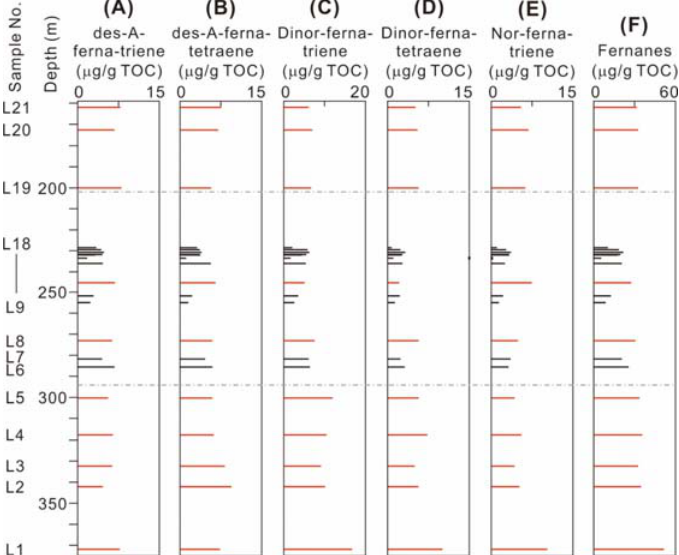
Figure 12. Fernanes in saturated and aromatic hydrocarbon fractions of oil shale and coal. ( A ) des- A-ferna-triene. ( B ) des-A-ferna-tetraene. ( C ) Dinor-ferna-triene. ( D ) Dinor-ferna-tetraene. ( E ) Nor- ferna-triene. ( F ) Total fernane concentration. The red bar represents oil shale, and the black bar represents coal. The two horizontal grey lines show the boundaries of the three units.